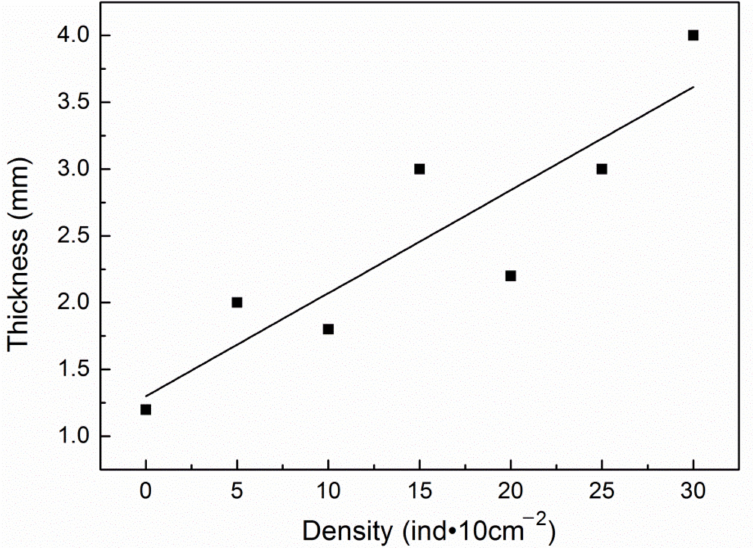
Figure 5. Thickness of fine sediment layer under seven biological